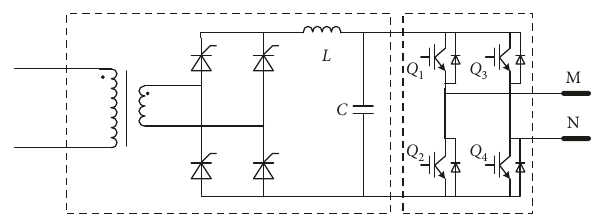
Figure 3: Controlled-source transmitter circuit using phase- controlled rectification.